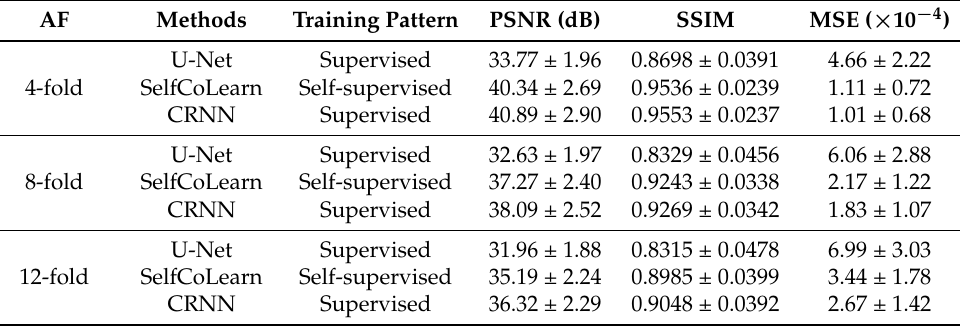
Table 2. Quantitative reconstruction results of different methods (Supervised U-Net, Supervised CRNN and SelfCoLearn) at 4-fold, 8-fold, and 12-fold acceleration factors (mean ± std). AF Methods